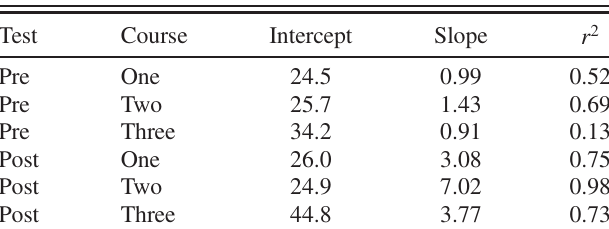
TABLE II. Linear models of the relationship between concept inventory score and course grade for pretest and post-tests.